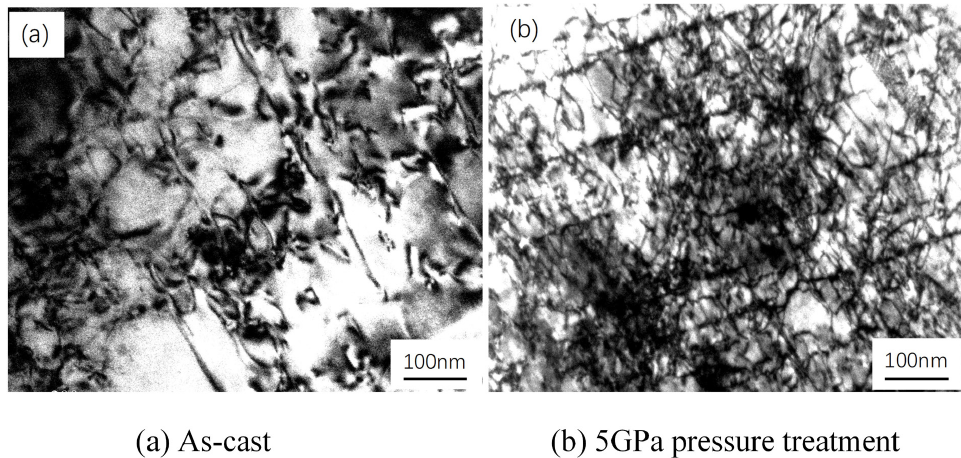
Fig.3 - TEM images of Cu-Al alloy before and after high pressure